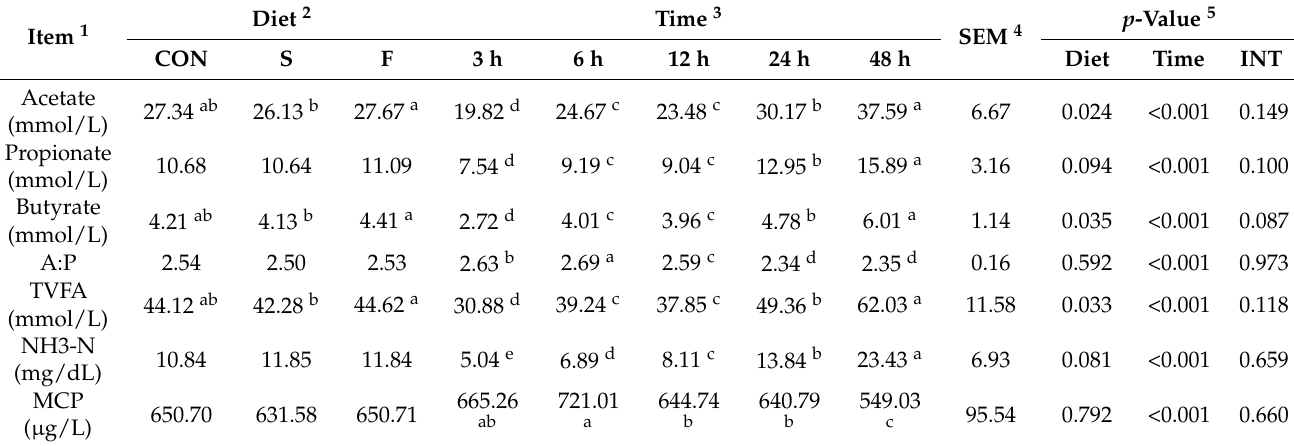
Table 2. Effects of oilseed treatments on in vitro VFA concentration and N metabolism.